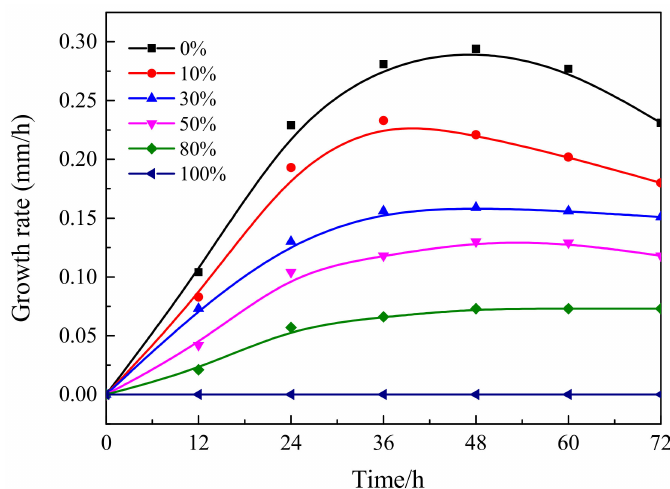
Figure 13. Antibacterial e ff ect of di ff erent concentrations of tunicate cellulose